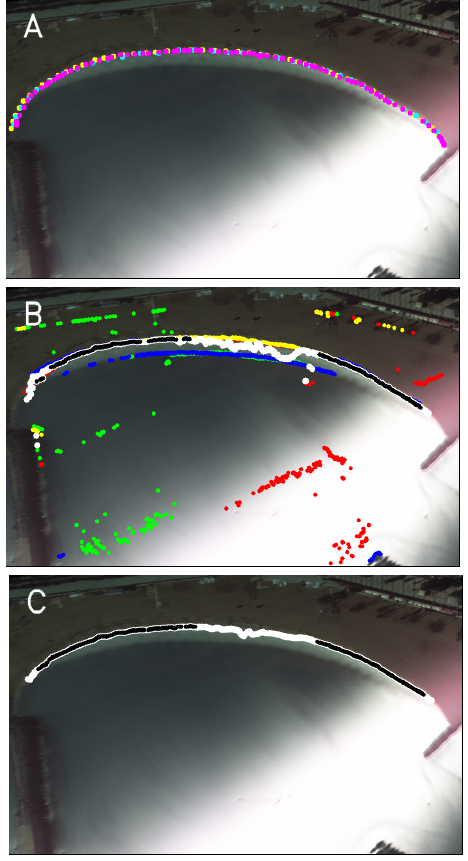
Figure 5. Equivalent to Figure 3, but of beach BCN3 on 7 November 2017 at 11 h. There is a strong contrast between the area with sun glare and the rest of the image, a phenomenon that occurs often in the studied